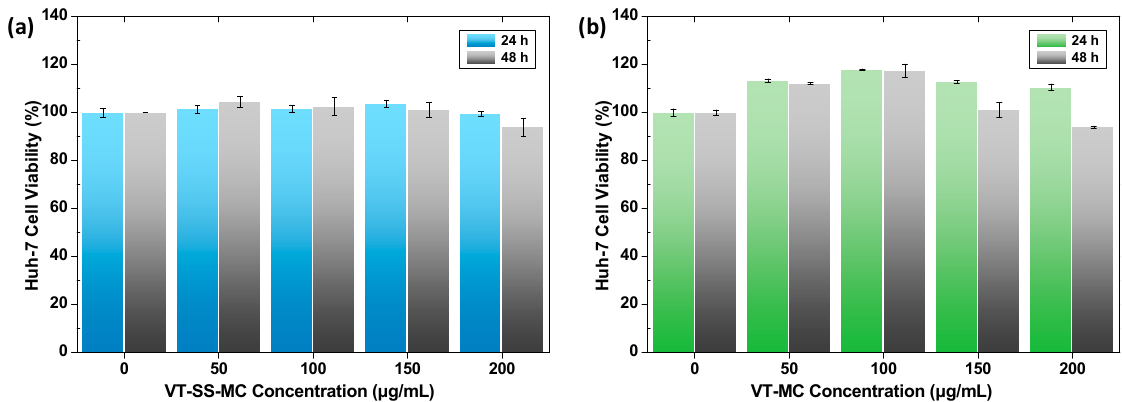
Figure 3. The viability of Huh-7 cells incubated with empty VT-SS-MC ( a ) and VT-MC vitamicelles ( b ) for 24 or 48 h was determined by CellTiter-Glo ® luminescent cell viability assay. Data are presented as the mean ± SD of triplicate experi- ments.